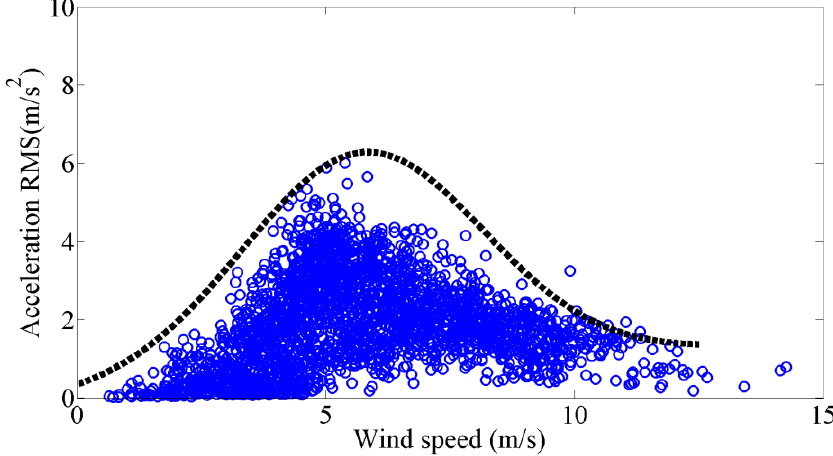
Figure 9. Vibration amplitude versus 10 min mean speed in April, July, and August.